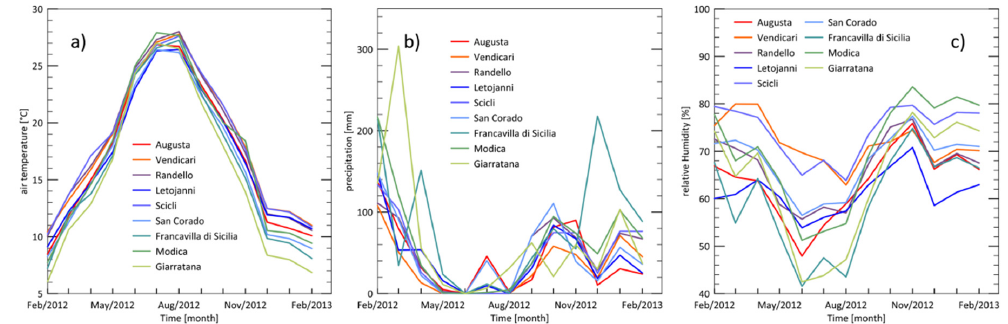
Figure 1. Monthly mean values of air temperature ( a ), total precipitation ( b ), and relative humidity ( c ) in the nine test sites. Time range: Feb./2012–Feb./2013. Rstudio version 1.2.5001 with R version 4.0.2 patched was used in testing for significant di ff